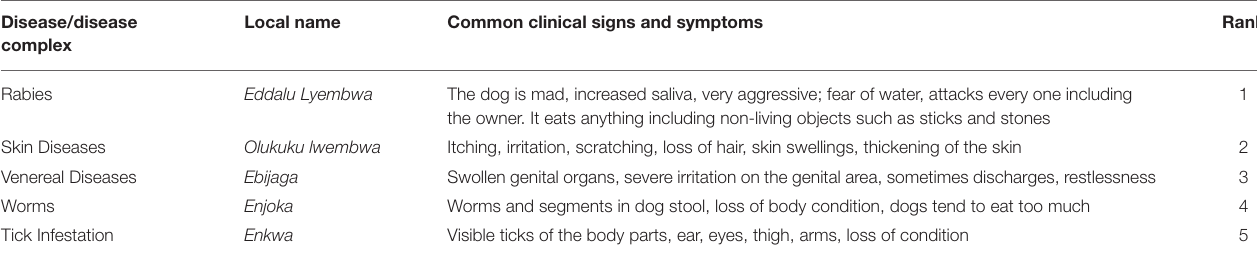
TABLE 2 | Signs, symptoms, and ranking of common dog diseases investigated by focus group discussions in Masaka district, Uganda. Disease/disease